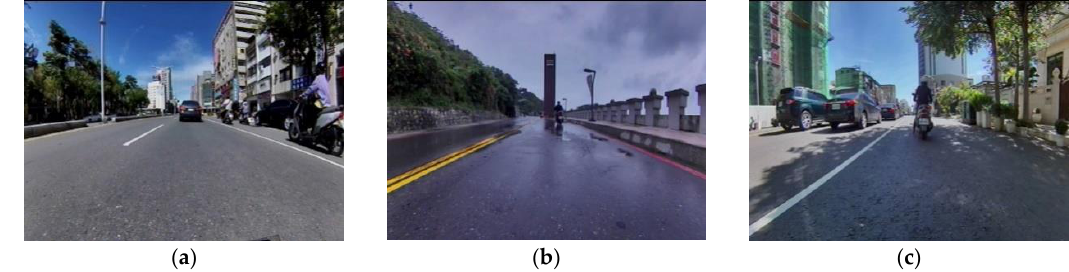
Figure 11. Experimental car and sensors setup.